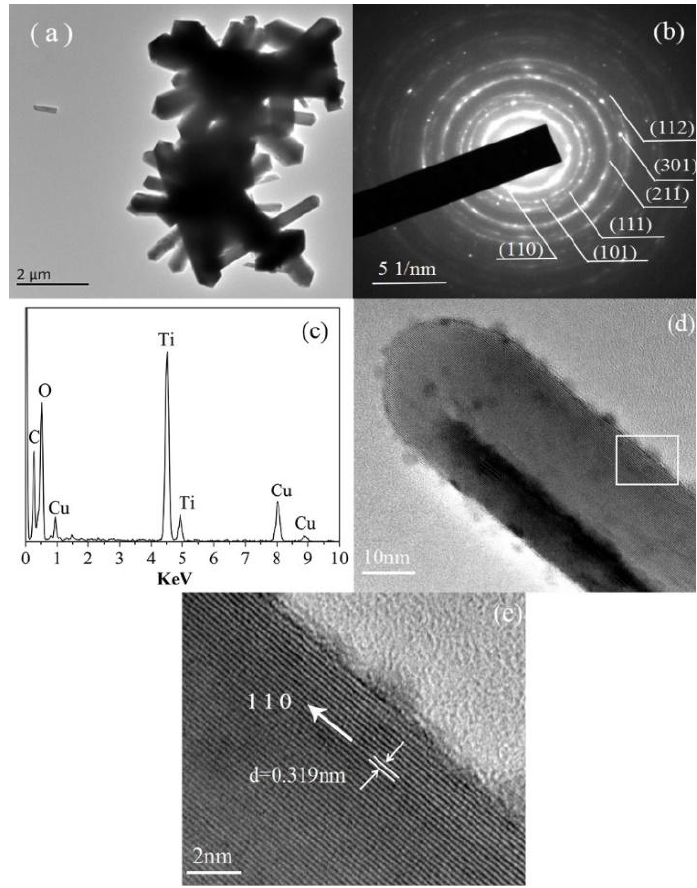
Figure 11. Characterization of TiO 2 nanorods. ( a ) Transmission electron microscopy (TEM) image of TiO 2 nanorods; ( b ) electron diffraction pattern of the TiO 2 nanorods; ( c ) energy dispersive X-ray spectrometry (EDX) spectrum from the TiO 2 nanorods; ( d ) TEM image of single TiO 2 nanorod;